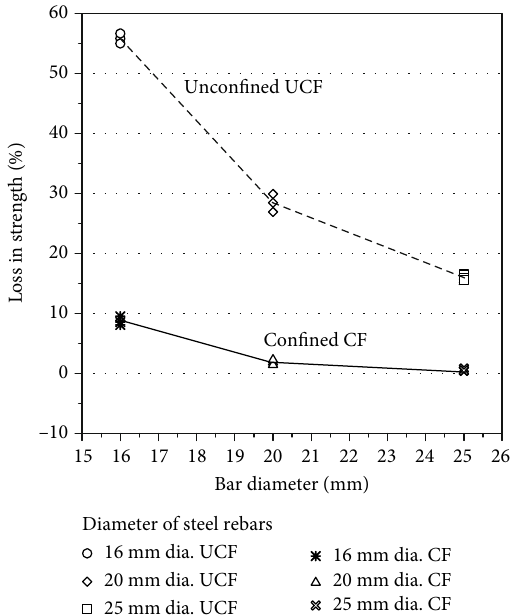
Figure 10: Loss of bond strength due to corrosion